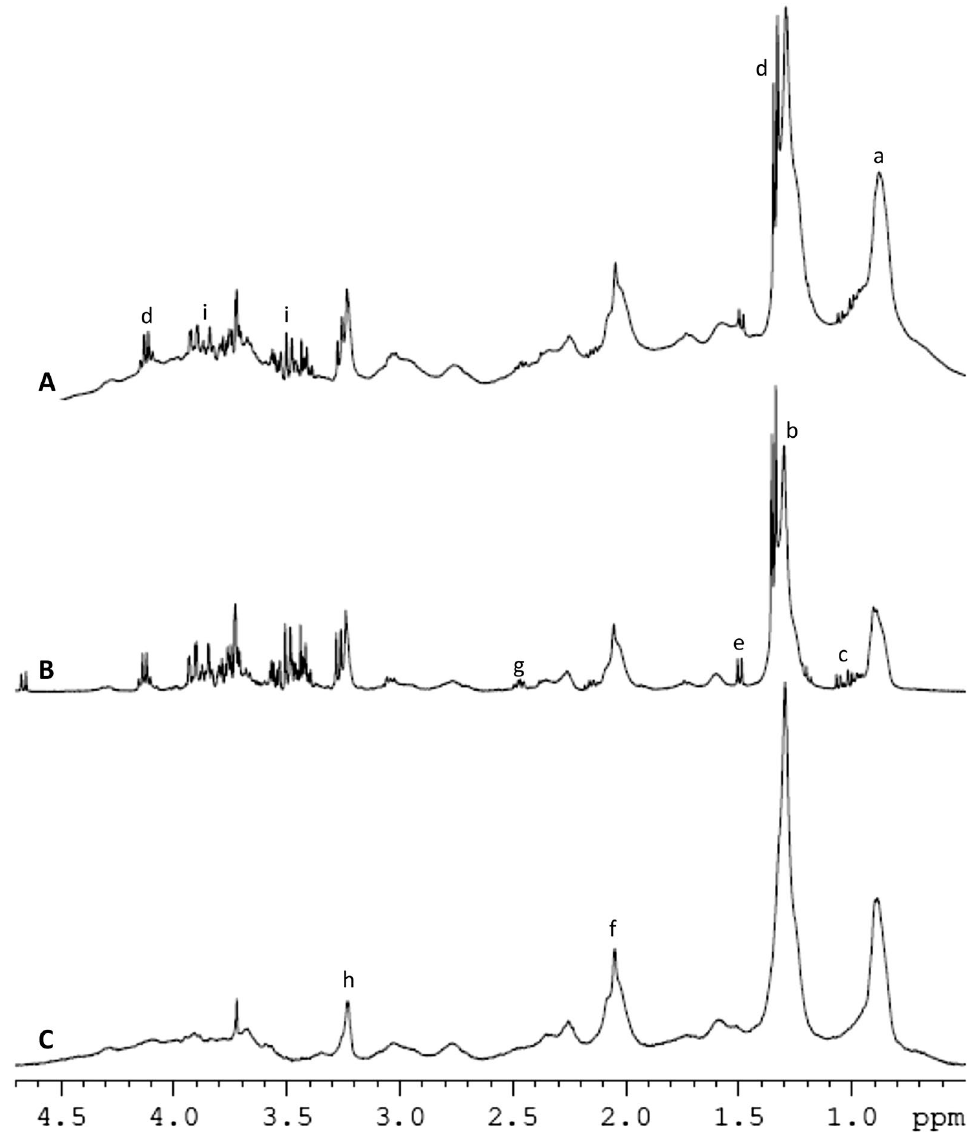
Figure 1. Typical serum spectra obtained from one patient using different pulse sequences. ( A ) pulse-and- acquire, ( B ) CPMG with an effective T2 delay of 32 ms and ( C ) diffusion edited spectra. Only the aliphatic part of the spectra is shown, spectra were acquired as described in the methods section. Tentative assignations based on chemical shift are as follows: (a) and (b) methyl end methylene groups of fatty acid chains in lipoproteins respectively; (c) Valine, leucine and isoleucine; (d) lactate; (e) alanine; (f) protons next to double bonds in fatty acid chains; (g) glutamate; (h) timethylamine containing compounds and (i) glucose.